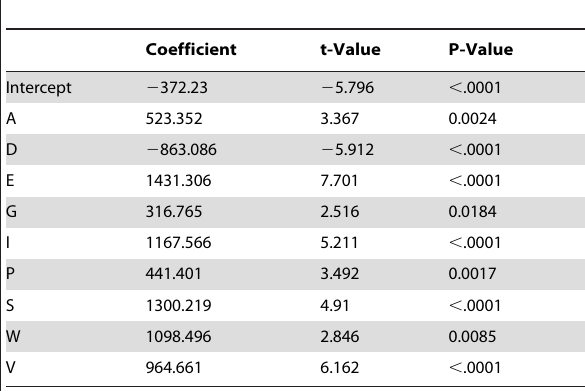
Table 1. Minimum adequate model for Ei , F =13.841; R 2 = 0.827, adj. R 2 =